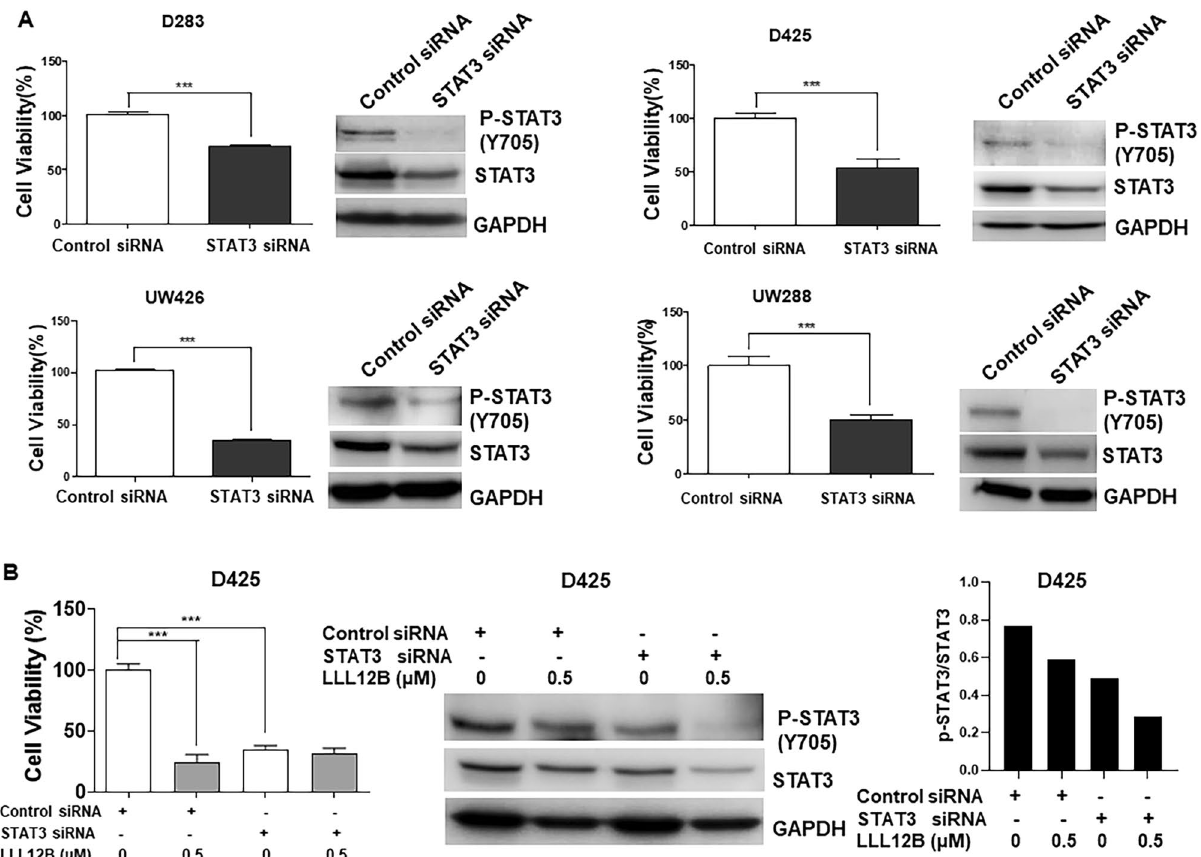
Figure 5. ( A ) Knock down of STAT3 by STAT3-specific siRNA inhibits STAT3 phosphorylation, STAT3 protein level and cell viability in D283, D425, UW426, and UW288 human medulloblastoma cell lines compared to Control siRNA. ( B ) Inhibition of STAT3 phosphorylation and cell viability by LLL12B or STAT3 siRNA. Cells were seeded for overnight, and transiently transfected with 100 nM of STAT3 siRNA or control siRNA for 24 h. After that, cells were cultured for 48 h then were treated with LLL12B (0.5 μM) or DMSO for additional 48 h. Cell viability was measured using MTT assay. Experiments were performed in triplicate and data are presented as means ± SE. *** P <